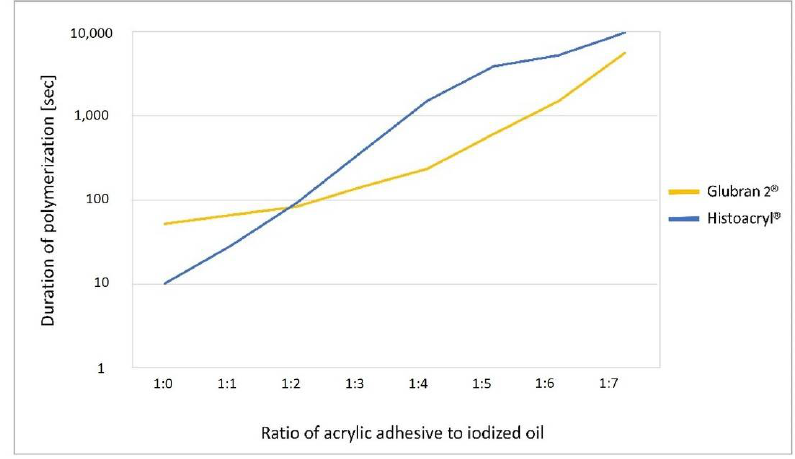
Figure 4. Duration of polymerization of acrylic adhesives (GL and HA) with varying ratios of